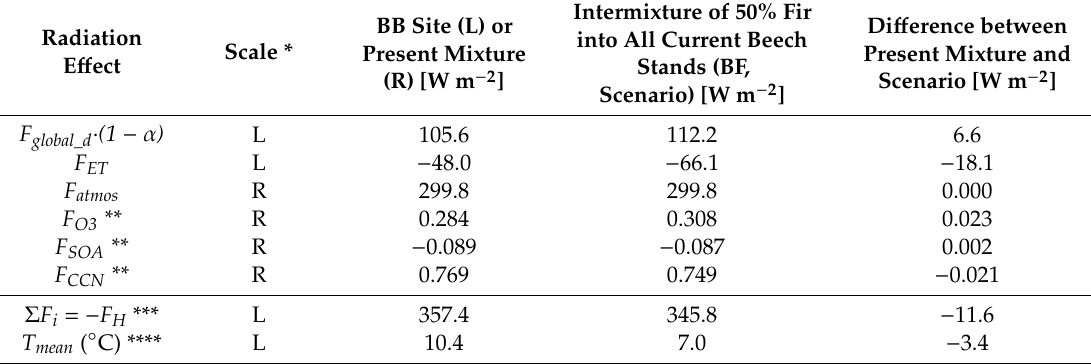
Table 3. Mean annual radiation contributions based on the year 2017 at Black Forest for the current tree distribution and an increased fir